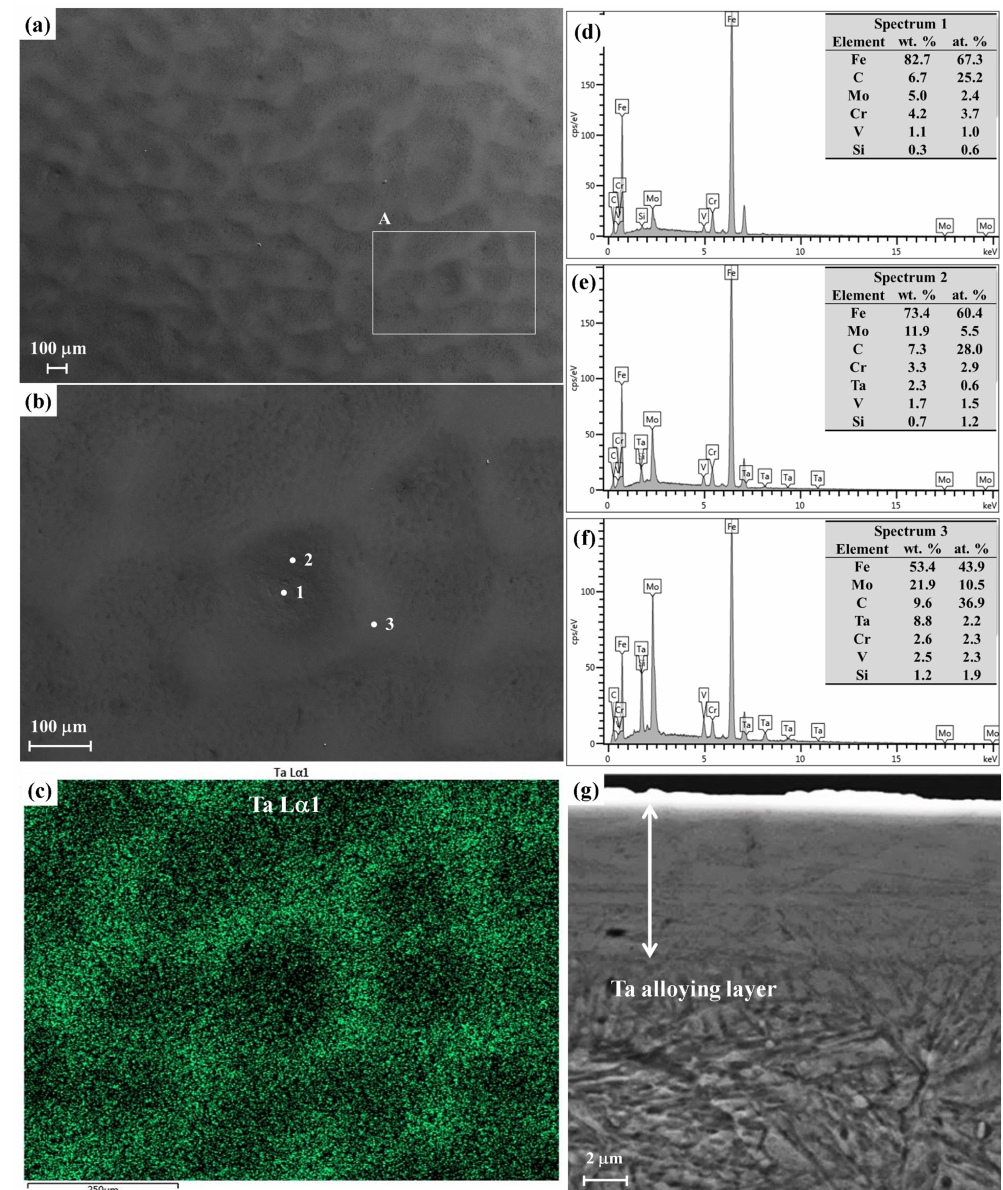
Figure 1. SEM/energy-dispersive X-ray spectroscopy (EDS) morphology characterization of a high-current pulsed electron beam (HCPEB)-treated Ta coating: ( a ) overview SEM topography; ( b ) high-magnification SEM image of region A; ( c ) EDS area-scanning spectrum of Ta in region A; ( d – f ) EDS spectra of points 1–3, respectively; ( g ) cross-section morphology. Note that the thickness of as-deposited Ta coating before HCPEB irradiation is 400